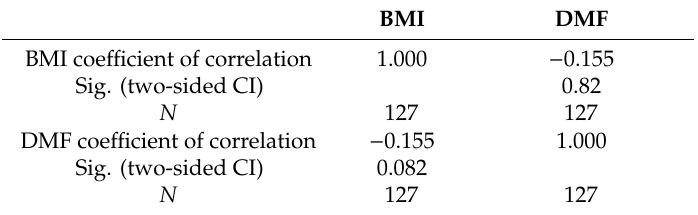
Table 7. Data related to the correlation between the BMI and DMF evaluated in the whole